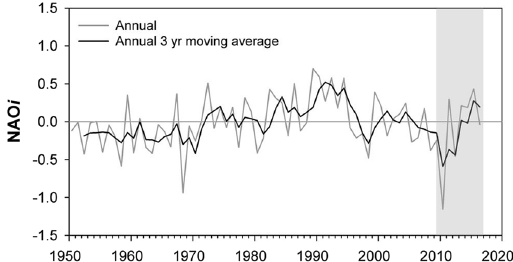
Figure 1. Time series of the North Atlantic Oscillation index ( NAOi ) provided by the NOAA Climate Prediction Centre (www.noaa.gov). The lines illustrate the annual average and annual antecedent simple three-year moving average NAOi , and the shaded area represents the period for high resolution monitoring of phosphorus and nitrogen concentrations in rivers interpreted in this study